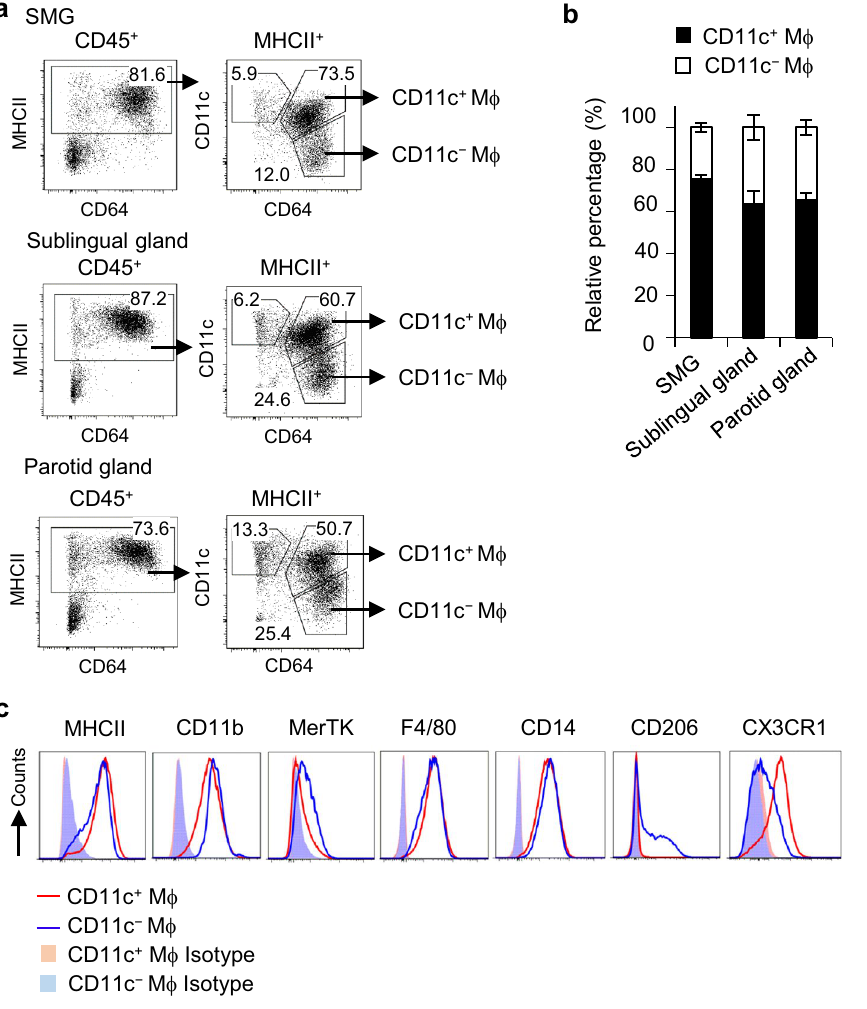
Figure 1. Phenotypes of macrophage subsets in steady-state SGs. Female C57BL/6N mice at 7–12 weeks old were used. ( a ) Gating strategy to identify macrophage subsets in steady-state SMGs, and sublingual and parotid glands by flow cytometry. Representative plots are shown. ( b ) Relative percentages of CD11c + and CD11c − macrophages in SMGs and the sublingual and parotid glands. Bars represent the mean ± SD of three mice per group. ( c ) Histograms represent the expression of surface markers. Red and blue lines represent the specific staining of CD11c + and CD11c − macrophages, respectively, while shaded histograms represent the unstained control. Results are representative of three independent experiments. Mϕ